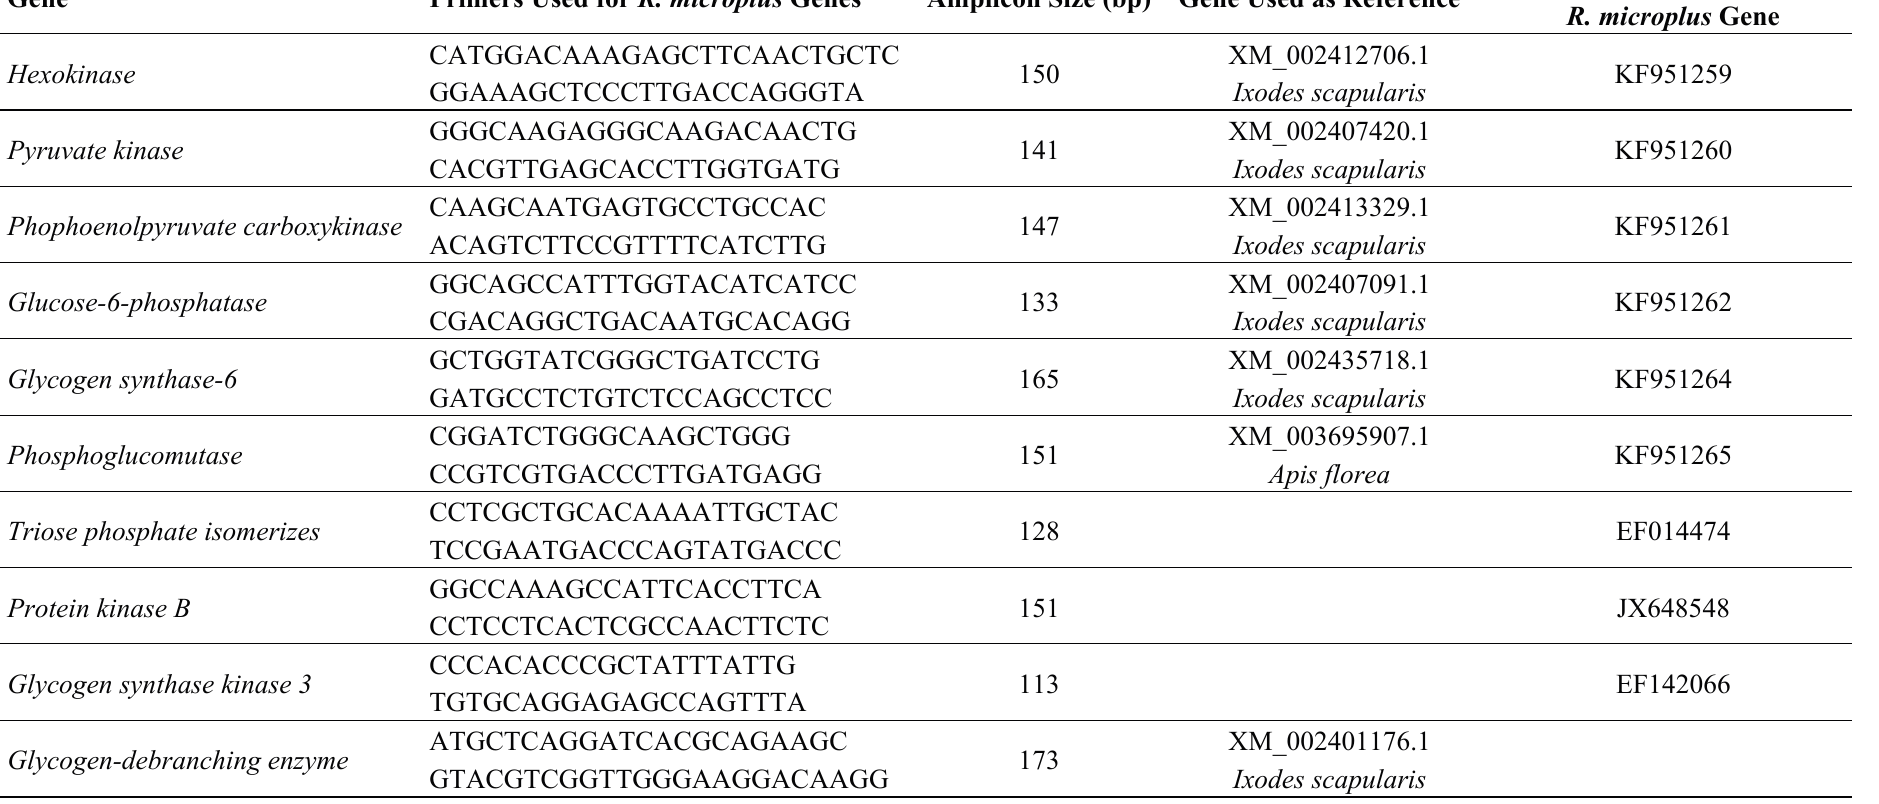
Table 1. The sequences of primers used for SYBR Green real-time PCR of genes involved in glycogen metabolism. Gene Primers Used for R. microplus Genes Amplicon Size (bp) Gene Used as Reference *